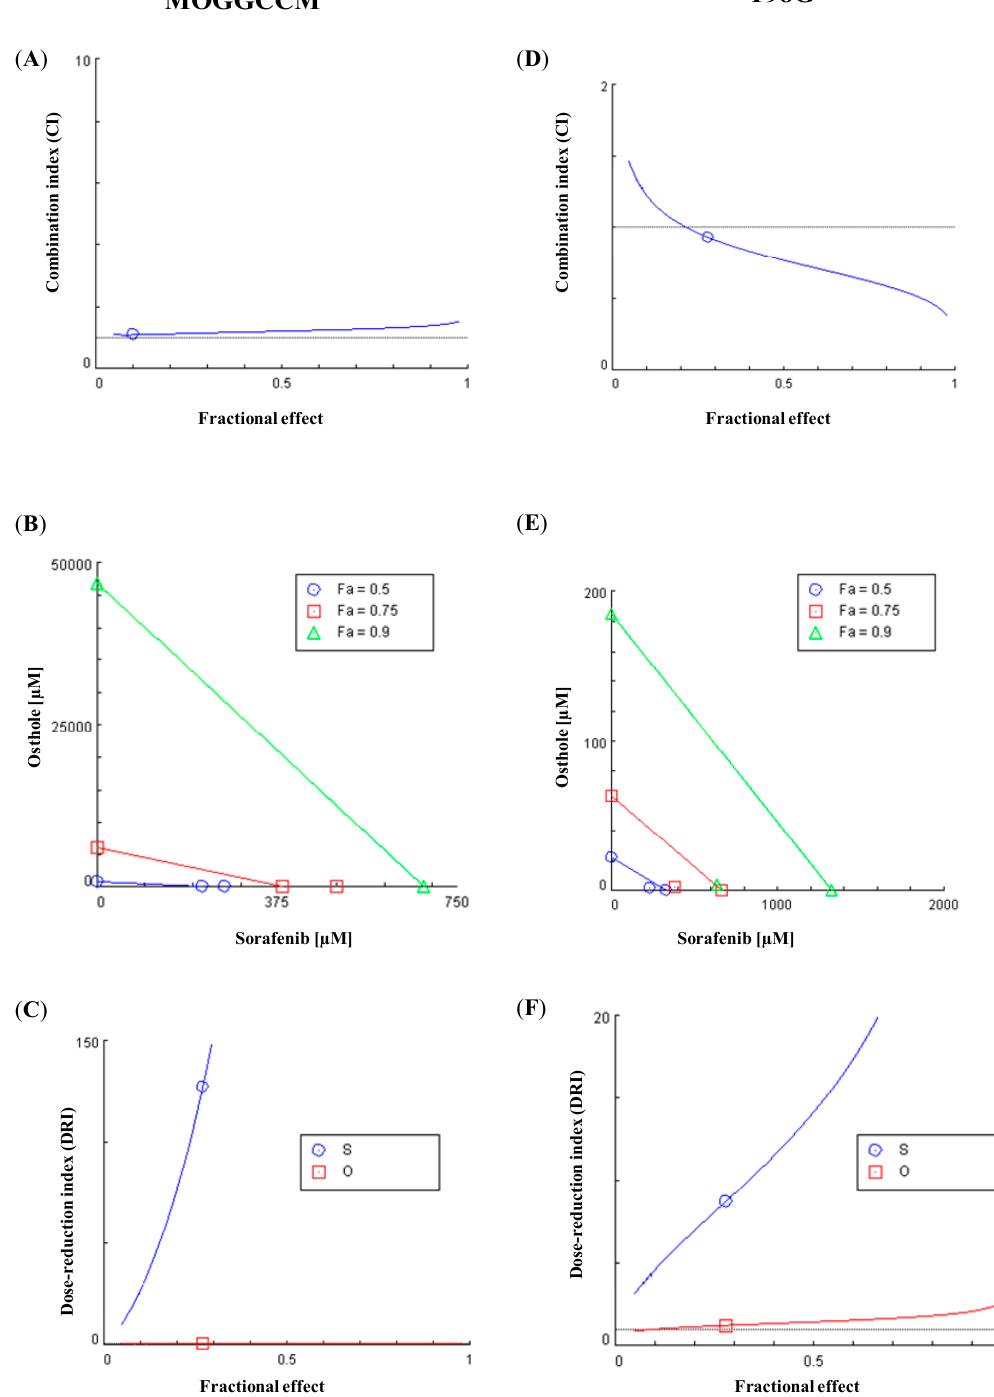
Figure 6. Osthole (O) and sorafenib (S) combination treatment in the MOGGCCM ( A – C ) and T98G ( D – F ) cell line. ( A , D ) Combination index (CI) plot: the combination index is plotted as a function of Fa (fractional effect, line of blue color). ( B , E ) Isobologram for the combination: classic isobologram at IC50, IC75, and IC90. ( C , F ) Fa-DRI (dose-reduction index) plot (Chou-Martin plot) .